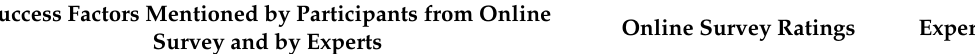
Table 10. Success factors mentioned by all survey